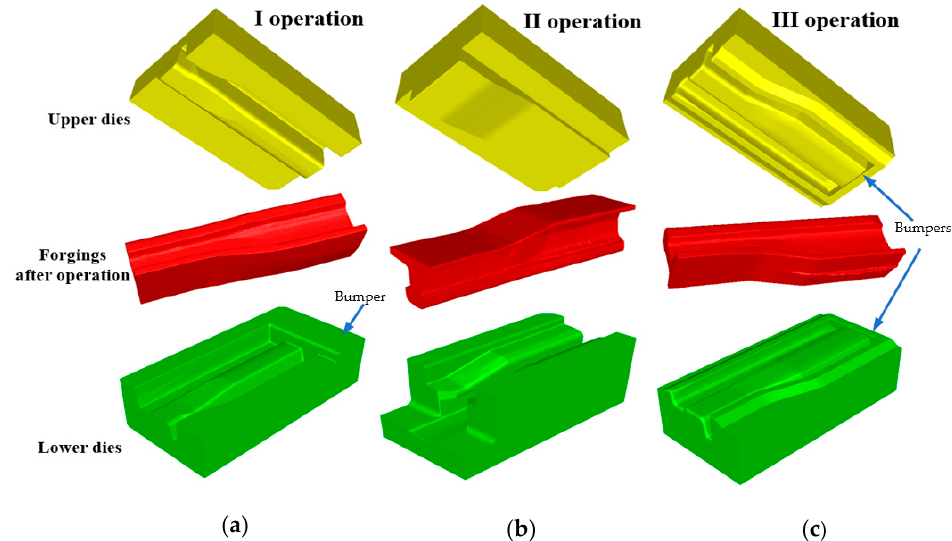
Figure 3. Final versions of CAD models of tools used to reforge needle rails from Pb at 1:4 scale: ( a ) for operation I, ( b ) for operation II, ( c ) for operation III.